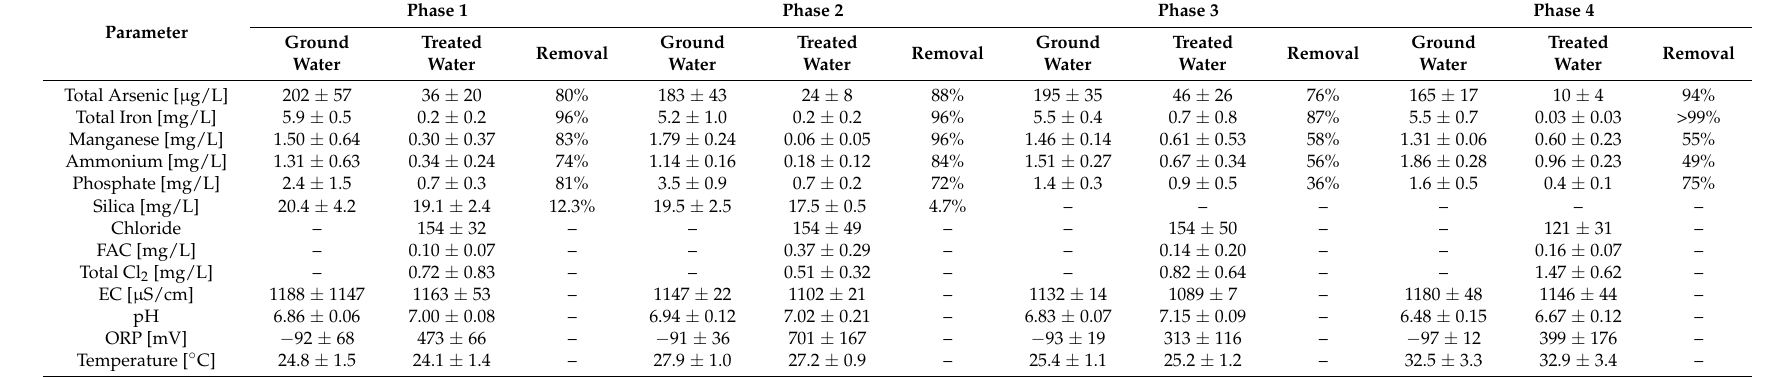
Table A1. Results from water quality monitoring, mean values and standard deviation, Kalyani treatment system, September 2016–July 2017.